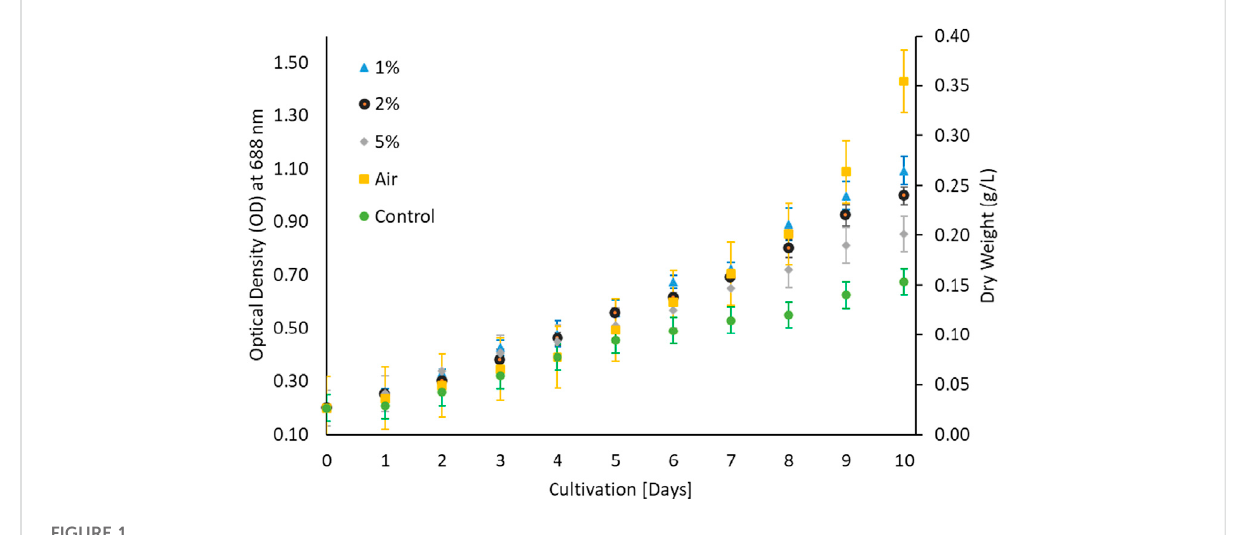
FIGURE 1 Different CO 2 concentrations in